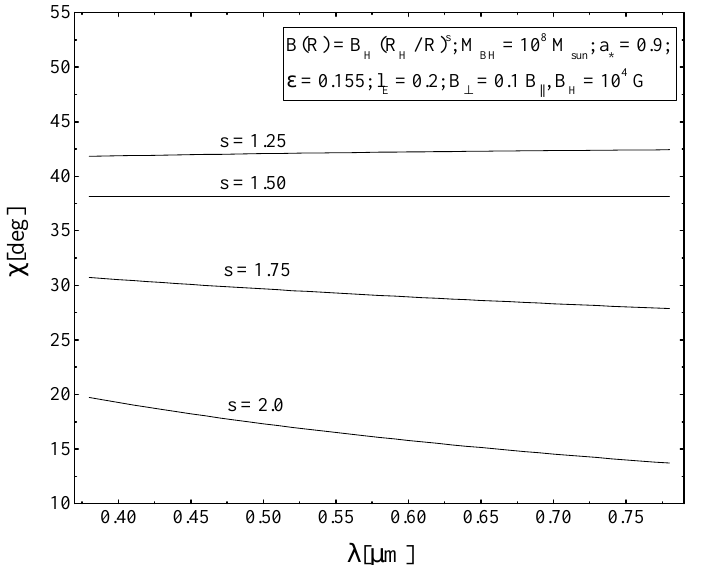
Figure 4. Dependence of the positional angle χ on the wavelength λ for different values of the parameter s